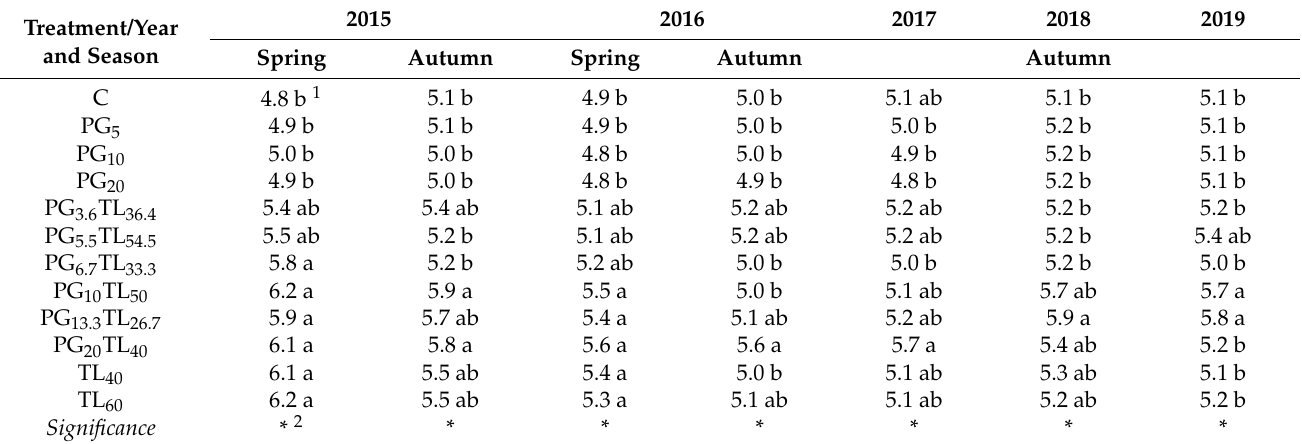
Table 8. Effect of treatments and years on the soil pH KCl at 0–20 cm